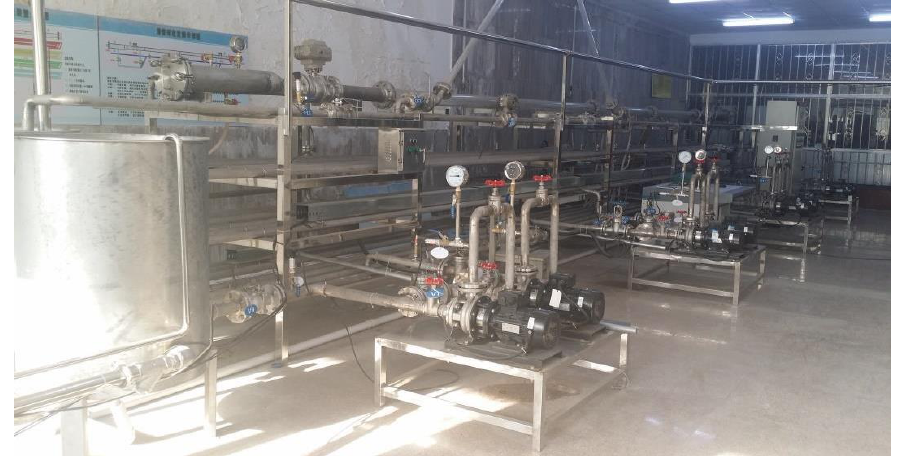
Figure 6. Photo of pipeline test bench. Table 1. List of laboratory